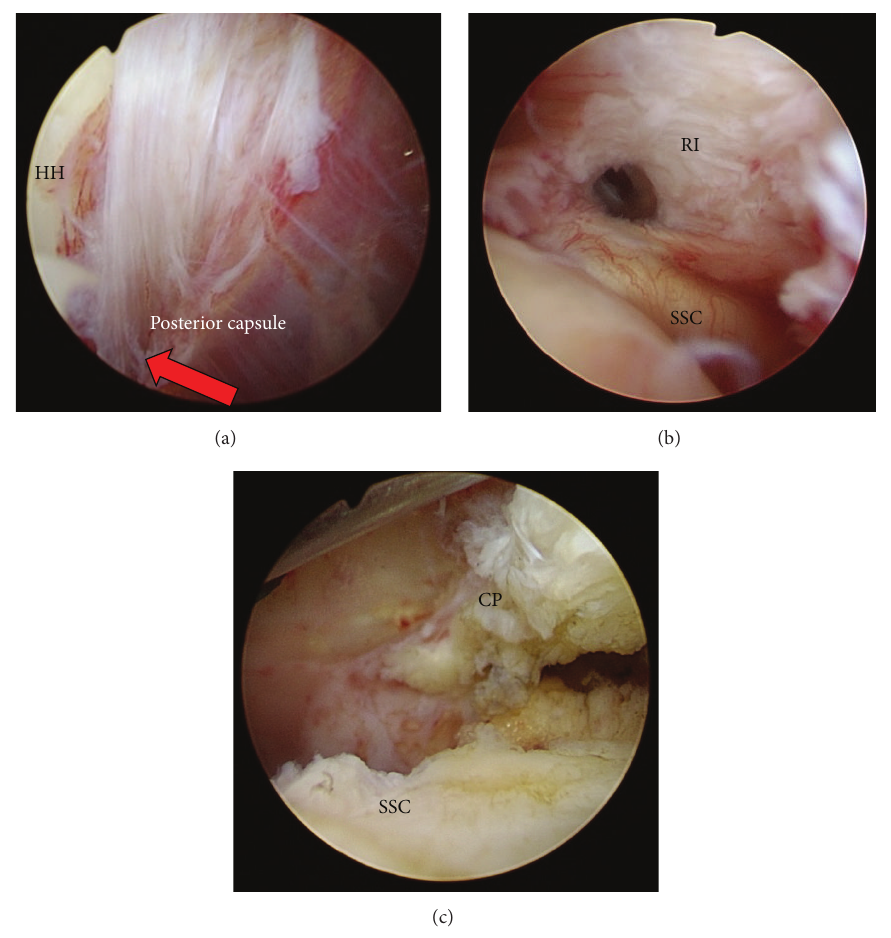
Figure 1: Arthroscopic findings in Case 1. SSC: subscapularis; RI: rotator interval; HH: humeral head; CP: coracoid process; PIGHL: posterior band of inferior glenoid humeral ligament. (a) Arrow shows that the posterior capsule was cut with a fresh stump. (b) Thickened RI and CHL remained. (c) Thickened anterior side of the CHL can be seen from the joint